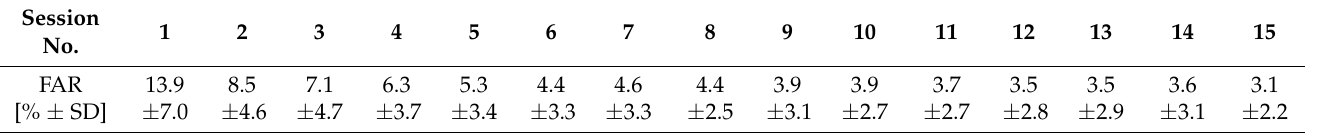
Table 6. The percentage of successful impostor attacks over all attack attempts (False Acceptance Rate,